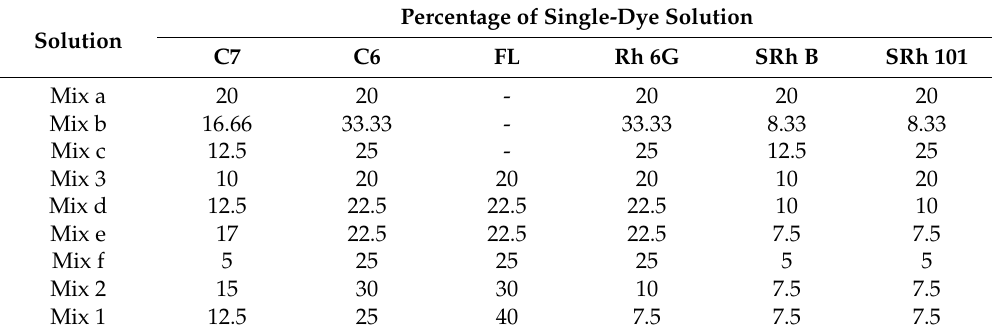
Table 2. Composition of dye-doped polymer solution